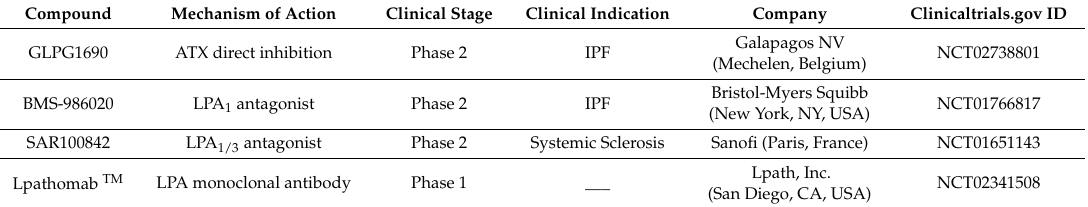
Table 1. Summary of novel targets of the ATX-LPA signaling axis currently in clinical